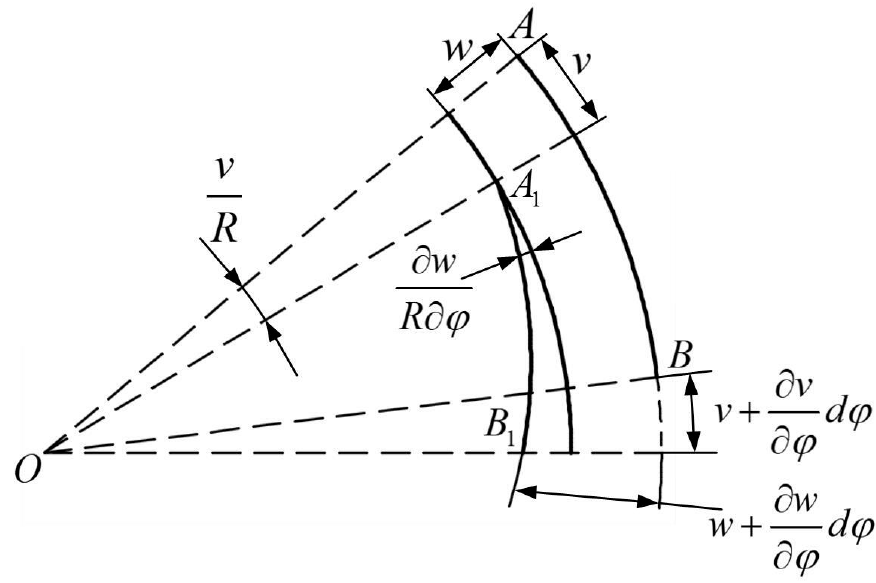
Figure A1. Deformation analysis on the circumferential direction.